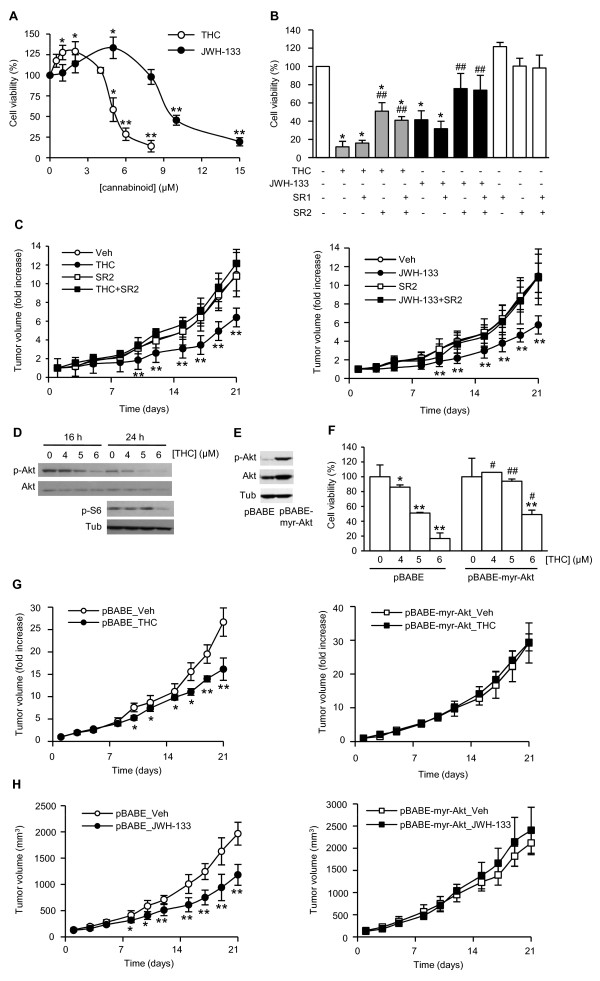
Akt downregulation is involved in cannabinoid antitumoral action. (A and B) Viability of N202.1A cells in response to (A) increasing concentrations of THC or JWH-133 or (B) 6 μM THC or 10 μM JWH-133 with or without 2 μM SR141716 (SR1) and/or SR144528 (SR2) for 48 h. Data are expressed as % of vehicle-treated cells, set at 100%. (C) Growth of N202.1A-derived xenografts treated with THC (left panel) or JWH-133 (right panel) with or without SR2. (D) Phospho-Akt and phospho-S6 ribosomal protein (p-S6) levels in N202.1A cells challenged with THC, as determined by Western blot. Total Akt and α-tubulin levels were used for normalization. (E) Phospho-Akt and total Akt levels in N202.1A cells retrovirally transduced with myristoylated Akt (pBABE-Myr-Akt) or the corresponding empty vector (pBABE). (F) Cell viability of pBABE- or myr-Akt-transduced N202.1A cells in response to THC exposure for 72 h. (G and H) Time course of the volume of pBABE-N202.1A-derived (left panels) and myr-Akt-N202.1A-derived (right panels) tumors treated with THC (G), JWH-133 (H) or the corresponding vehicle. *, p < 0.05; **, p < 0.01 vs vehicle-treated cells or tumors; #, p < 0.05; ##, p < 0.01 vs cannabinoid alone-treated cells (B) or vs THC-treated pBABE-transduced cells (F).